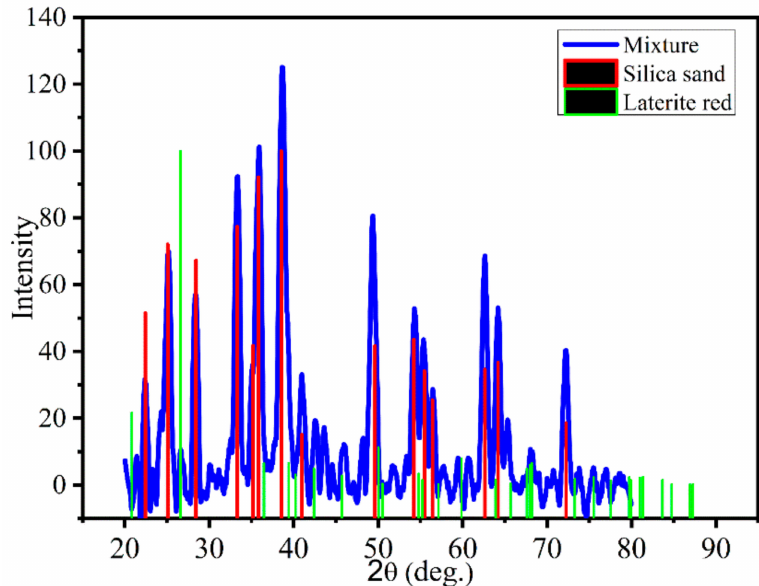
Figure 18. XRD of laterite red and silica sand.